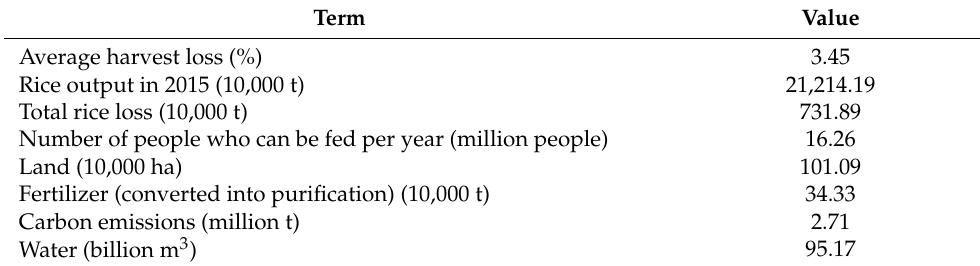
Table 3. Impact of rice harvest losses on natural resources and the environment.